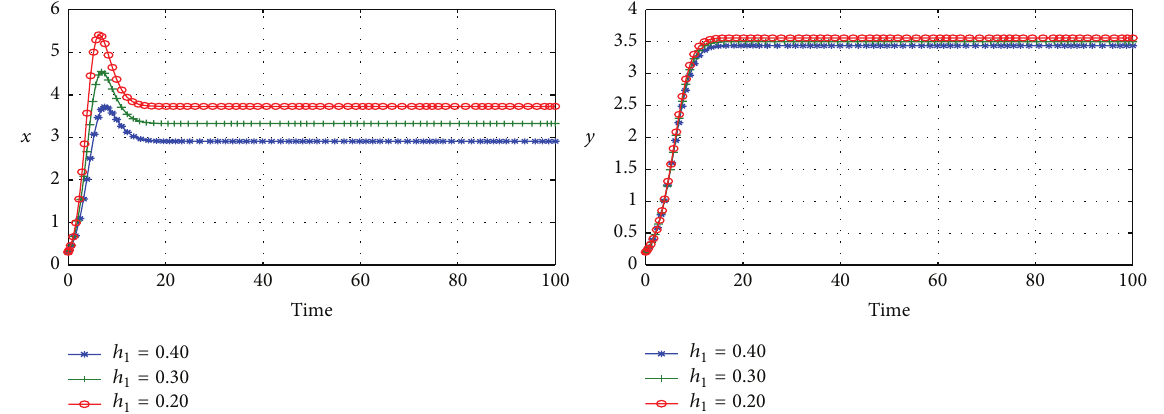
Figure 3: When ℎ 2 = 0.5 and ℎ 1 decreases, prey species 𝑥 and predator species 𝑦